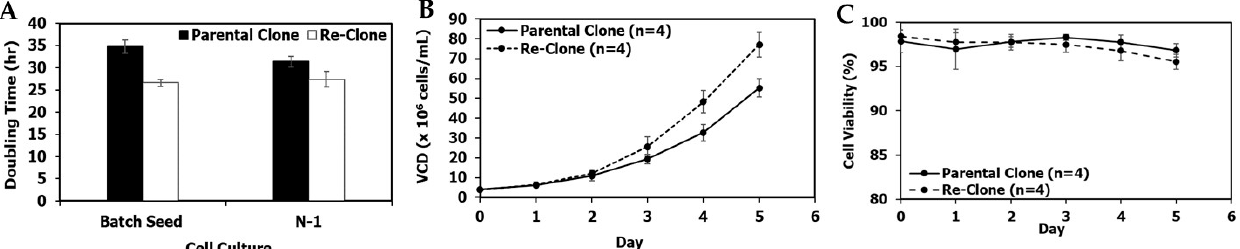
Figure 6. mAb2 seed and N-1 culture performance of the parental and re-clone. ( A ) Doubling times for the shake flask batch seed cultures and the N-1 5-L cultures, ( B ) N-1 fed-batch 5-L bioreactor viable cell density (VCD), ( C ) N-1 viability. The values are reported as average ± standard deviation (n = 4).